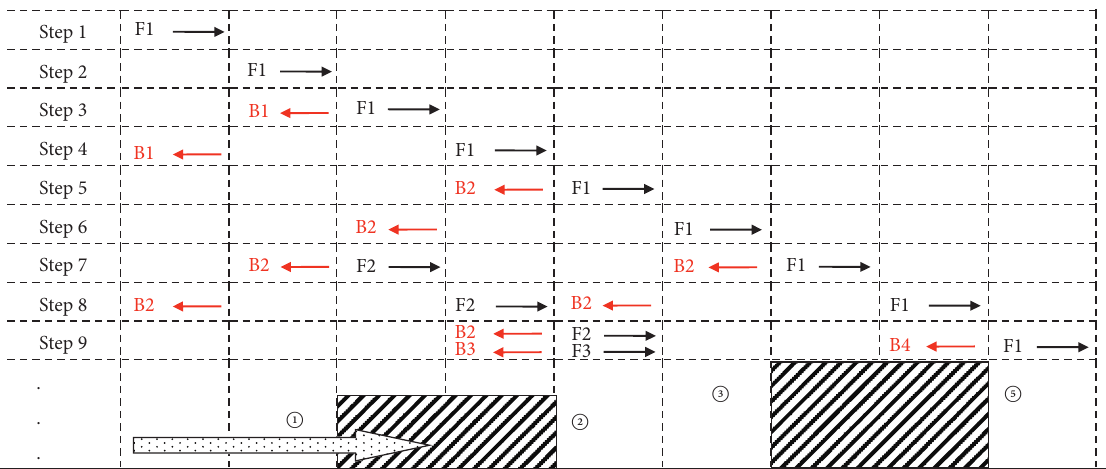
Figure 5: Schematic diagram of the propagation paths inside the